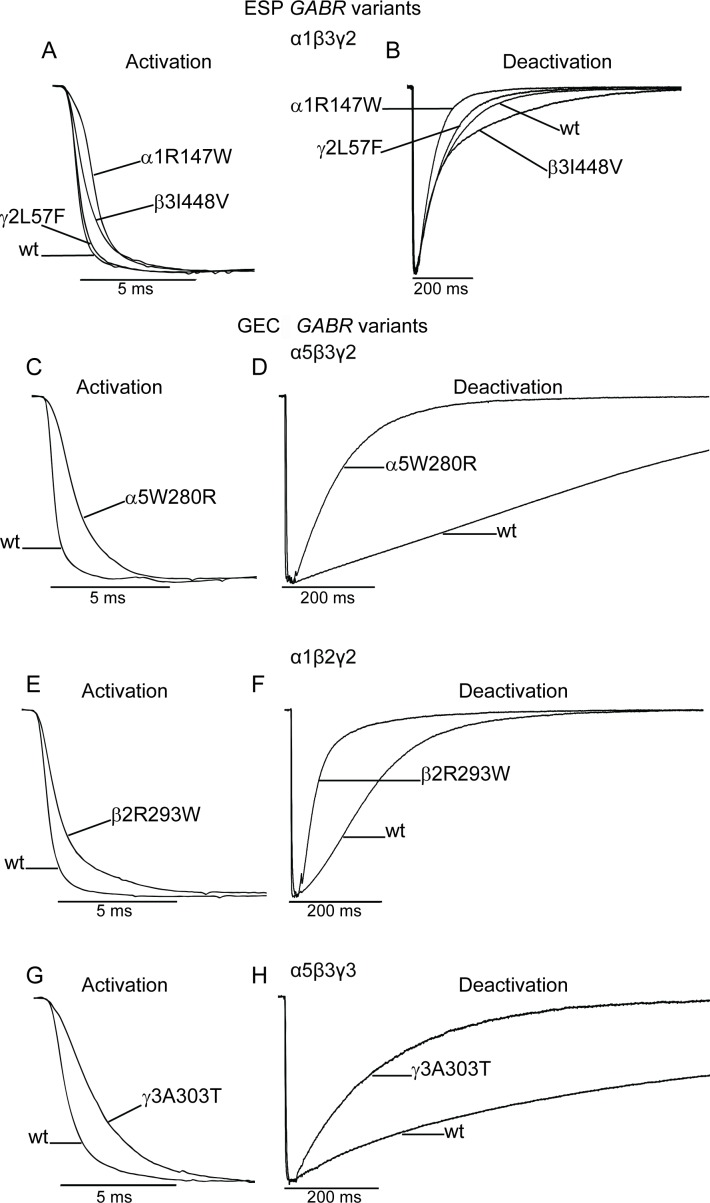
Deleterious GABR variants altered the kinetic properties of GABA-evoked currents.Representative current traces showing activation (A, C, E, G) and deactivation (B, D, F, H) properties of wild type (wt) and variant subunit-containing receptors were obtained following rapid application of GABA (1 mM, 10 ms). (A, B) GABA-evoked currents from cells expressing wild type α1β3γ2 GABAA receptors and α1β3γ2 receptors containing α1R147W, β3I448V, and γ2L57F, which were all scored as deleterious by PolyPhen-2. (C-H) GABA-evoked currents from cells expressing α5β3γ2 (C and D), α1β2γ2 (E and F), and α5β3γ3 (G and H) wild type and variant GABAA receptors. The variants α5W280R (C, D), β2R293W (E, F), and γ3A303T (G, H) were all scored as deleterious by PolyPhen-2. Traces are normalized for clarity.